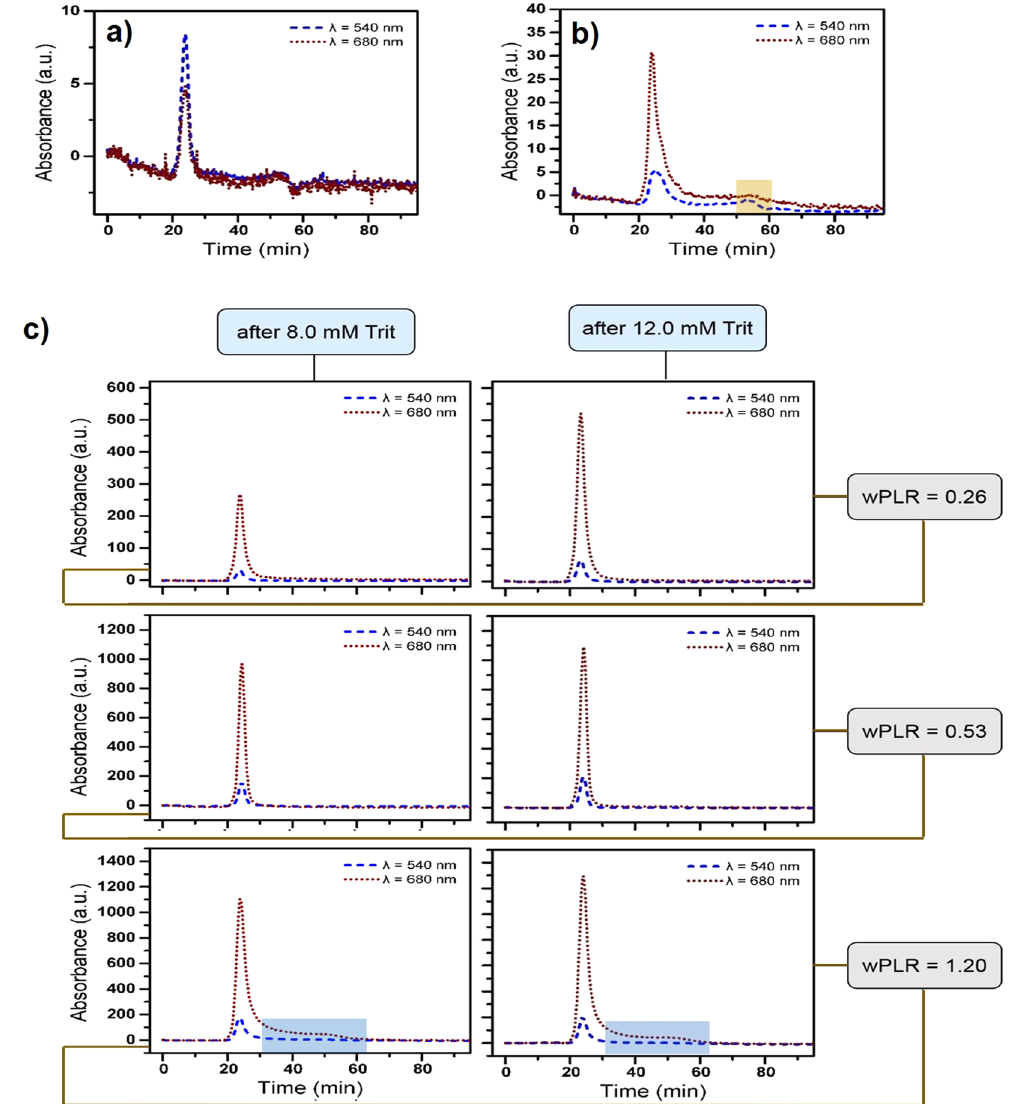
Figure 4. SEC elution profiles of: ( a ) control DPhPG liposomes; ( b ) TX-100 solubilized PSI; and ( c ) PSI- proteoliposomes based on optimal wavelengths of absorbance at 540 (blue dashed lines) and 680 nm (red dot lines) for liposomes and PSI respectively. Shadowed fractions in ( b ) corresponds to detergent micelles. Shadowed fractions in ( c ) for PSI-proteoliposomes at wPLR = 1.2 correspond to individually unassociated PSIs or shredded